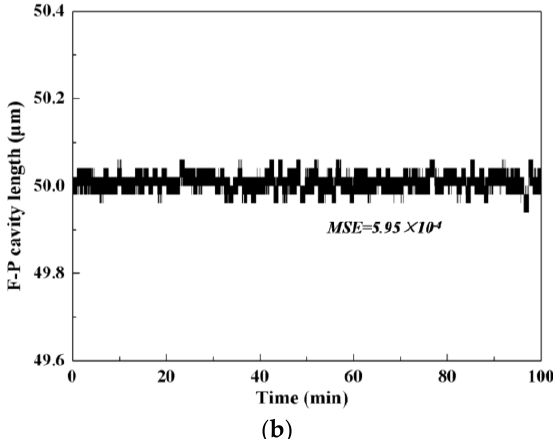
Figure 7. ( a ) The schematic and measurement equipment of the experiment; ( b ) the cavity length results of the sensor in the humid and high-pressure environment. MSE: mean squared error.